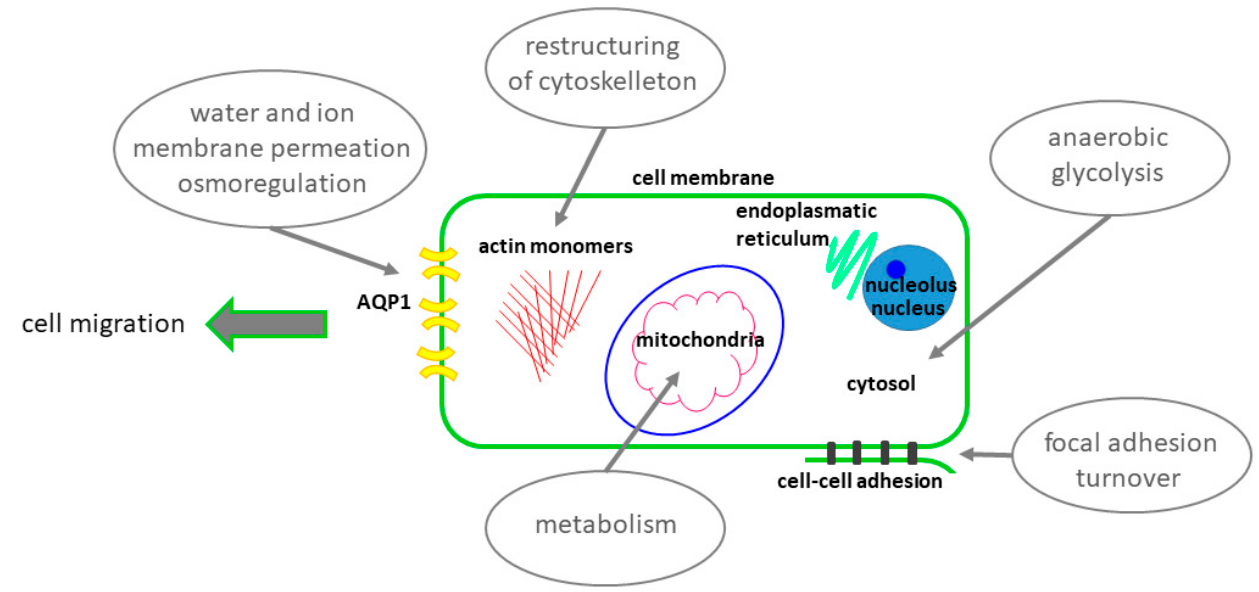
Figure 3. Possible heat generators and sources of thermogenesis in the migrating cell. Schematic overview of cellular processes that might contribute to increased thermogenesis of the migrating cell such as water and ion membrane permeation, osmoregulation, restructuring if cytoskelleton, anaerobic glycolysis, focal adhesion turnover or mitochondrial metabolism.